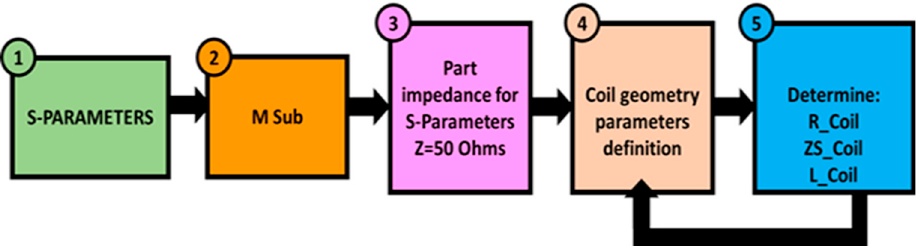
Figure 9. Block diagram of the coil form factor and the efficiency optimization using ADS.